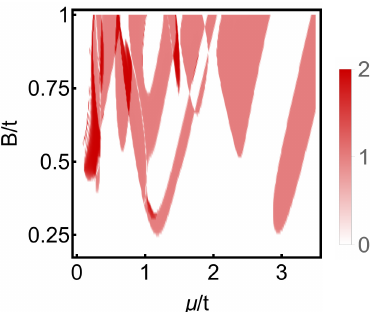
Figure 8: The total MP as a function of the chemical potential and a magnetic field perpen- dicular to the plane for Z strips. We consider a ribbon of width of W = 5 a , for α = 0.5 t and ∆ = 0.2 t , same as in Fig. 3b) for an in-plane field.